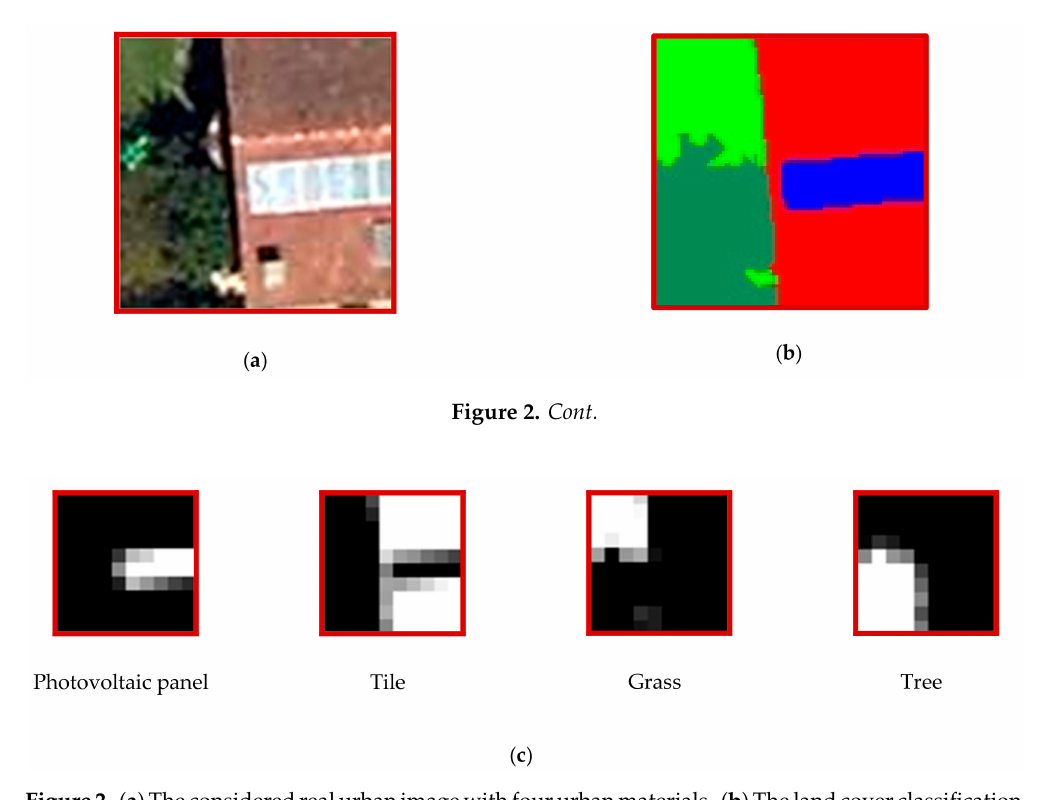
Figure2. ( a )Theconsideredrealurbanimagewithfoururbanmaterials. ( b )Thelandcoverclassification, with four classes: photovoltaic panel, tile, grass and tree, of the considered real urban image. ( c ) The four created abundance fraction